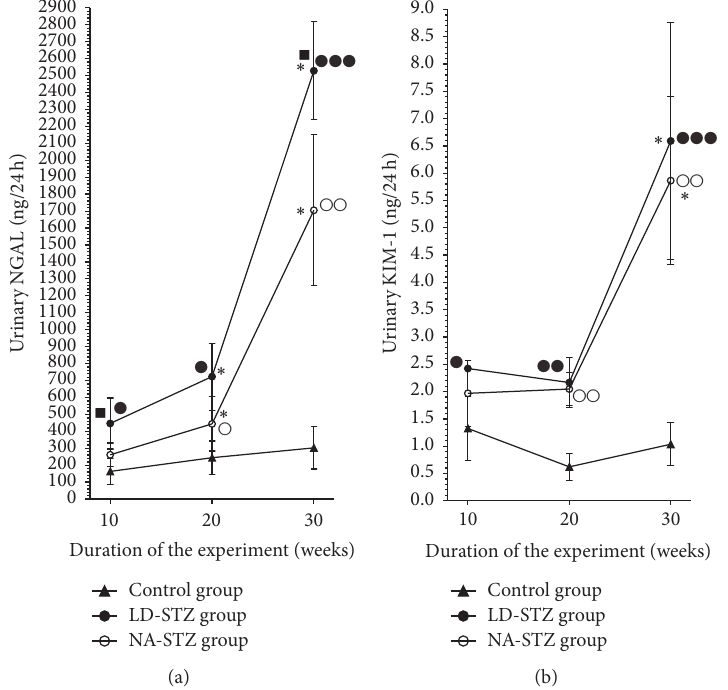
Figure 7: Dynamics of renal tubular injury markers in control, NA-STZ, and LD-STZ groups throughout the experiment. (a) Changes in urinary excretion of NGAL (ng/24h) measured at 10, 20, and 30 weeks of the experiment in the studied groups. (b) Changes in urinary excretion of KIM-1 (ng/24h) measured at 10, 20, and 30 weeks of the experiment in the studied groups. Mean values and standard deviations are shown. I – 𝑃 < 0.05 , II – 𝑃 < 0.01 in NA-STZ diabetic group versus control nondiabetic group at the same point of measurement. e – 𝑃 < 0.05 , ee – 𝑃 < 0.01 , and eee – 𝑃 < 0.005 in LD-STZ diabetic group versus control nondiabetic group at the same point of measurement. ◼ - 𝑃 < 0.05 in LD-STZ group versus NA-STZ group at the same point of measurement. ∗ 𝑃 < 0.05 compared to the first measurement in the same group at week